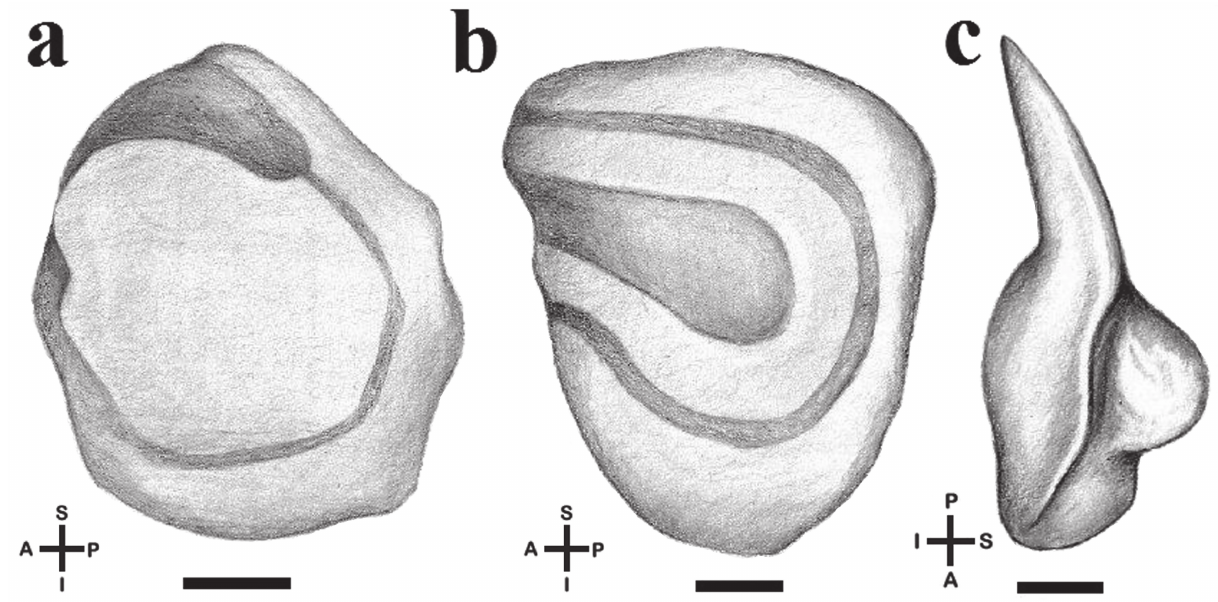
Fig. 8. Right serie of otoliths of Rineloricaria steinbachi (a) Lapillus, Scale bar = 100 µm; (b) Asteriscus, Scale bar = 100 µm; (c) Sagitta, Scale bar = 100 µm.